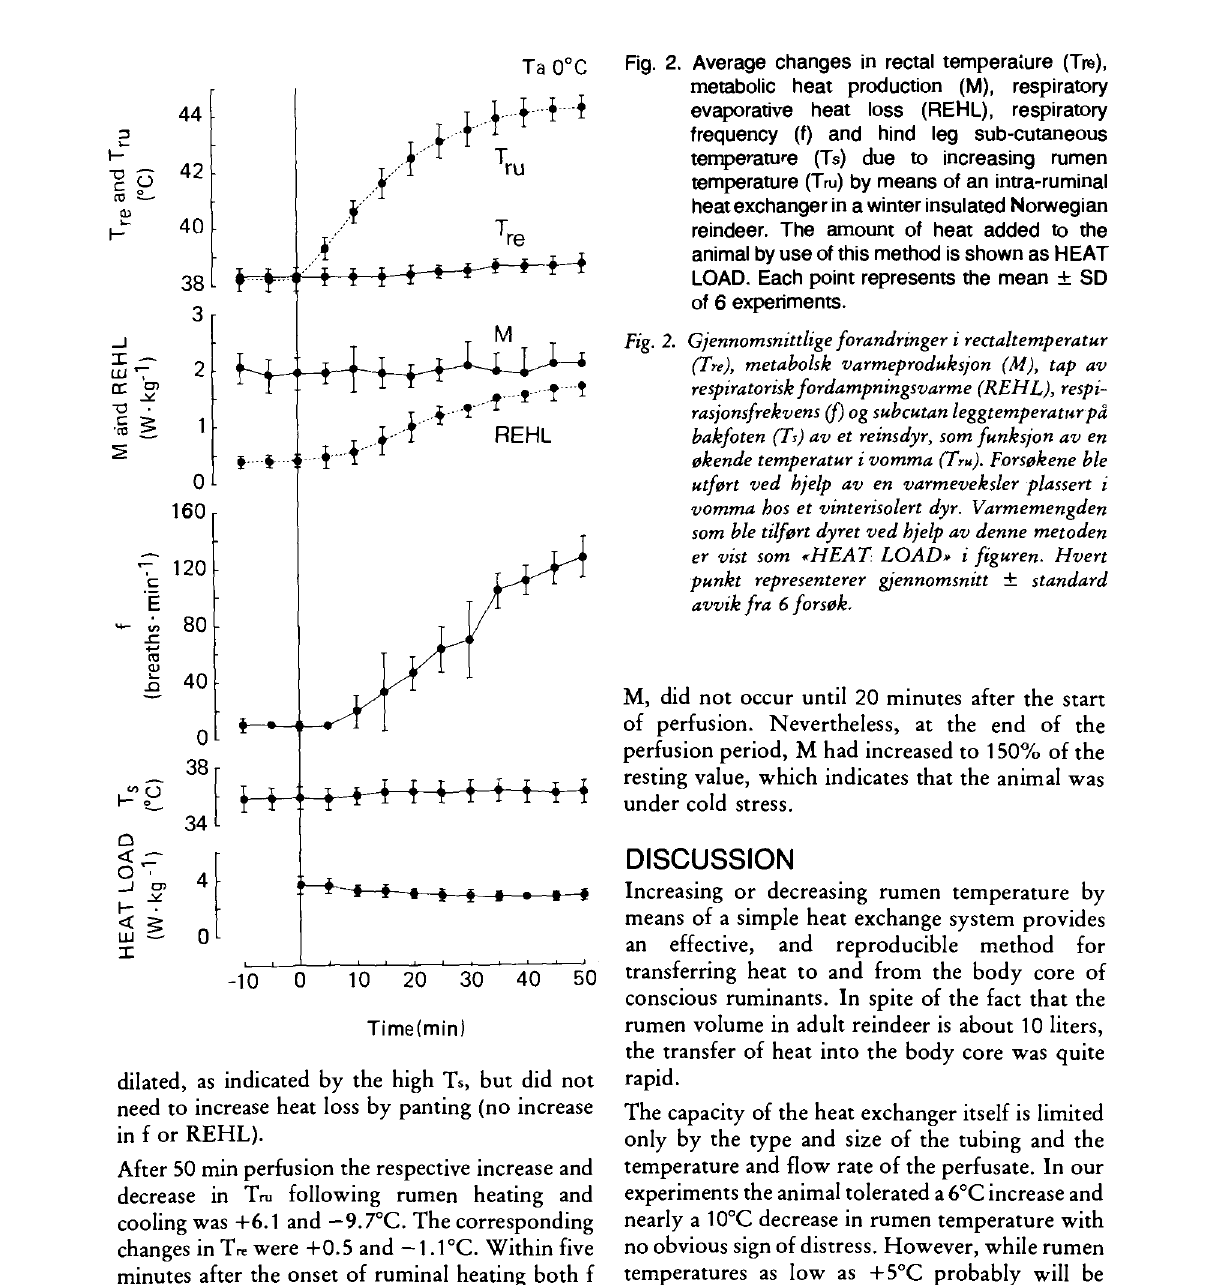
Fig. 2. Average changes in rectal temperature (Tre), metabolic heat production (M), respiratory evaporative heat loss (REHL), respiratory frequency (f) and hind leg sub-cutaneous temperature (Ts) due to increasing rumen temperature (Tm) by means of an intra-ruminal heat exchanger in a winter insulated Norwegian reindeer. The amount of heat added to the animal by use of this method is shown as HEAT LOAD. Each point represents the mean ± SD of 6 experiments. Fig. 2. Gjennomsnittlige forandringer i rectaltemperatur (Tre), metabolsk varmeproduksjon (M), tap av respiratorisk fordampningsvarme (REHL), respi- rasjonsfrekvens (f) og subcutan leggtemperatnr på bakfoten (T;) av et reinsdyr, som funksjon av en økende temperatur i vomma (Tru). Forsøkene ble utført ved hjelp av en varmeveksler plassert i vomma hos et vinterisolert dyr. Varmemengden som ble tilført dyret ved hjelp av denne metoden er vist som «HEAT LO AD» i figuren. Hvert punkt representerer gjennomsnitt ± standard avvik fra 6 forsøk.